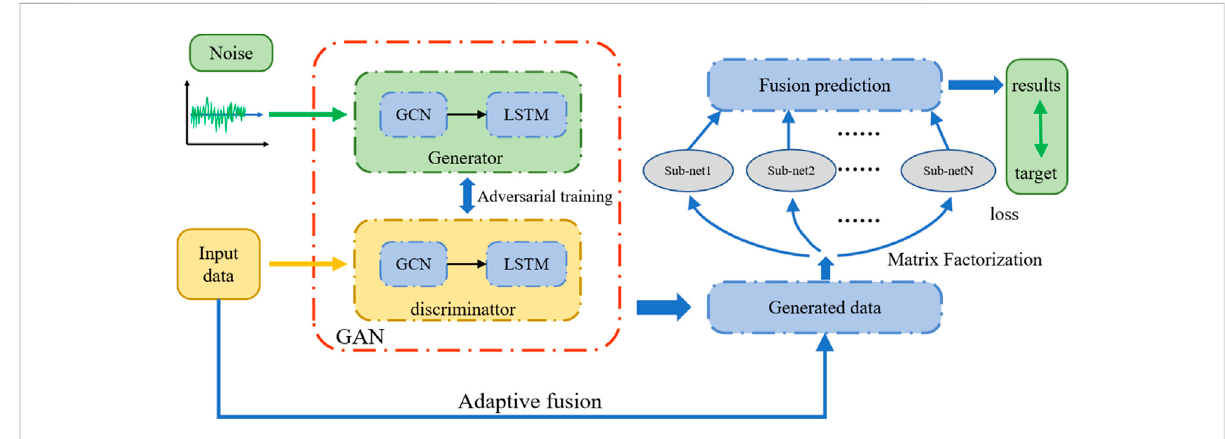
FIGURE 2 The framework of